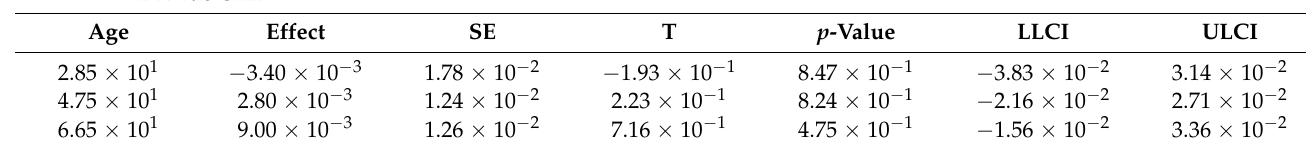
Table 1. Conditional effects of PWVao on skin SAF at the values of the moderators in the cohort n = 309. Three representative age values were chosen. SE stands for standard error. T-value is abbreviated as